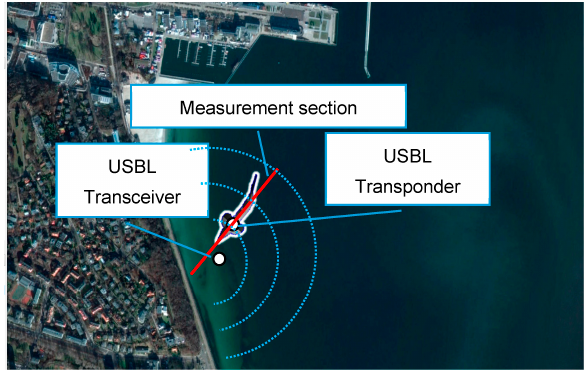
Figure 7. Measuring testing ground.